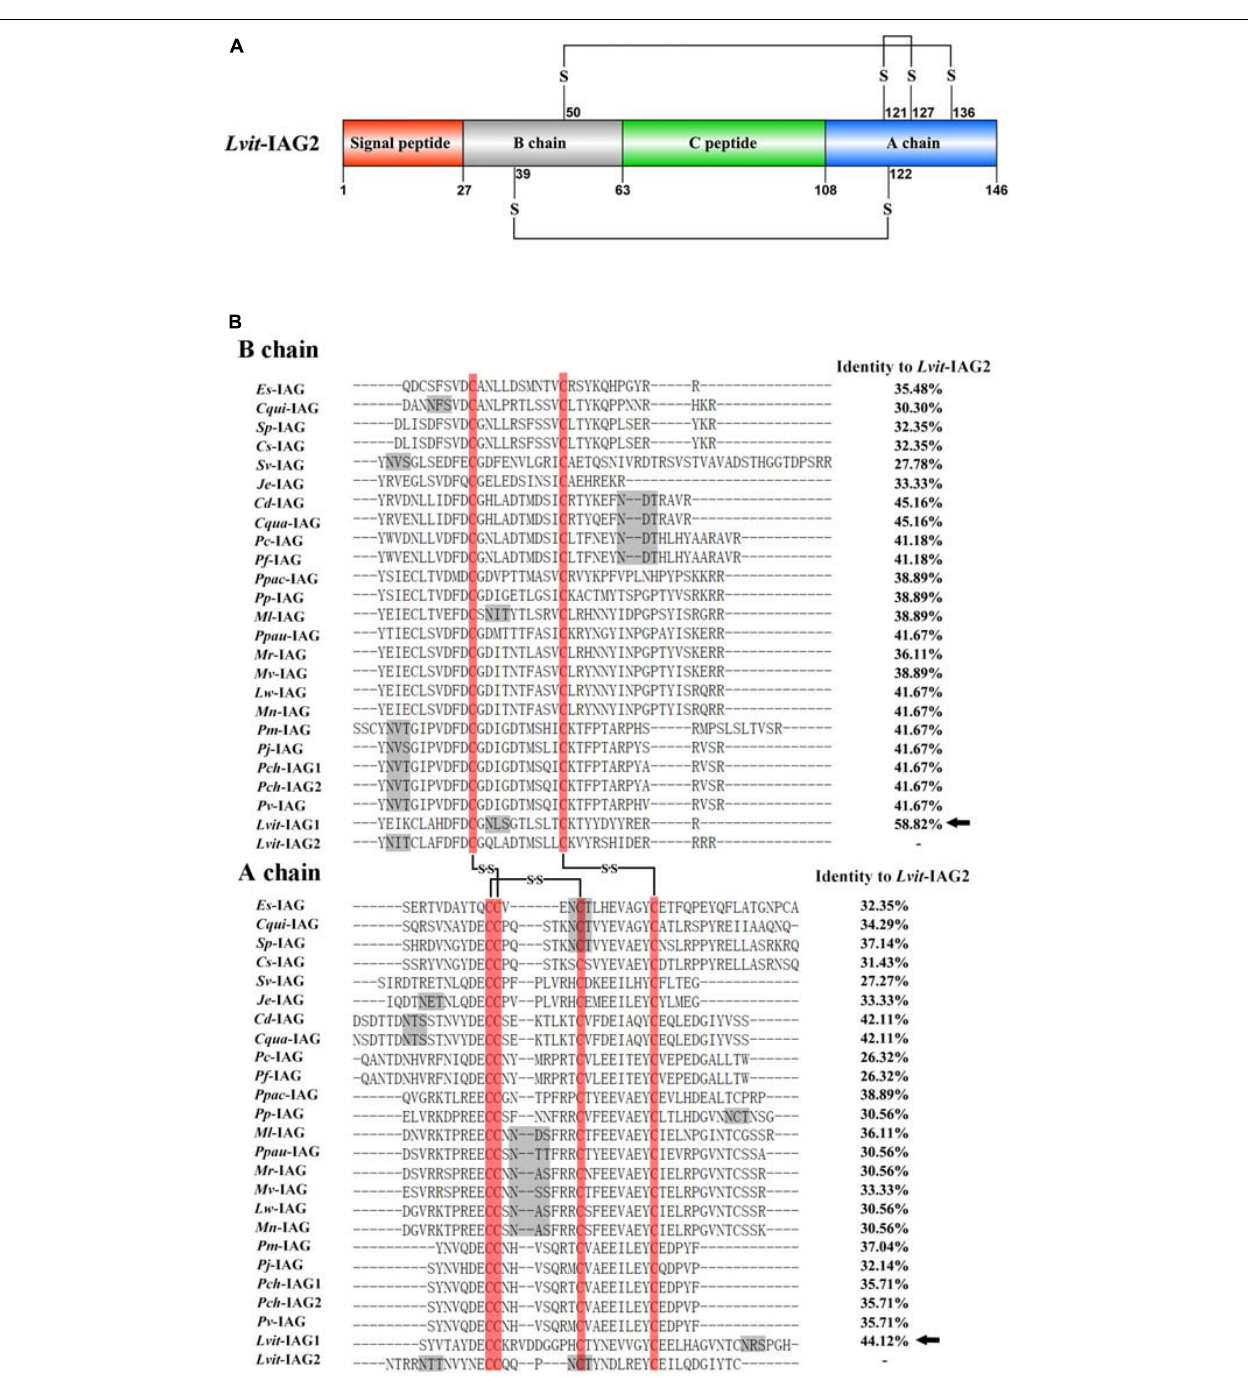
reached a peak at stage I, decreased sharply at stage II, and were continuously maintained at low levels at stages III and IV [ F ( 3 , 16 ) = 19.797, p < 0.05]. Similar trend was observed